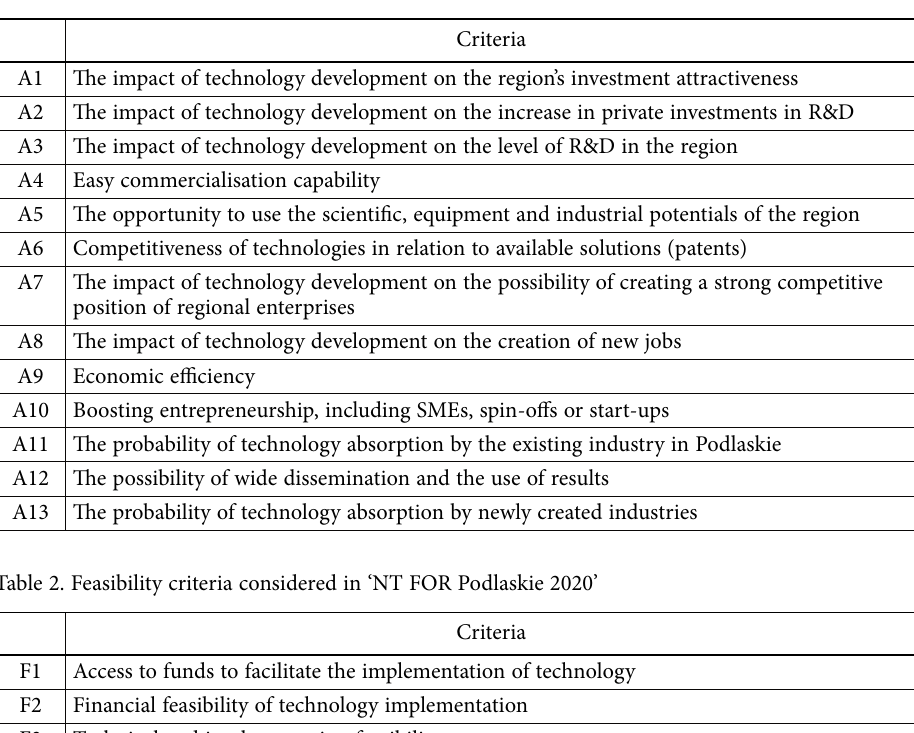
Table 1. Attractiveness criteria considered in ‘NT FOR Podlaskie 2020’